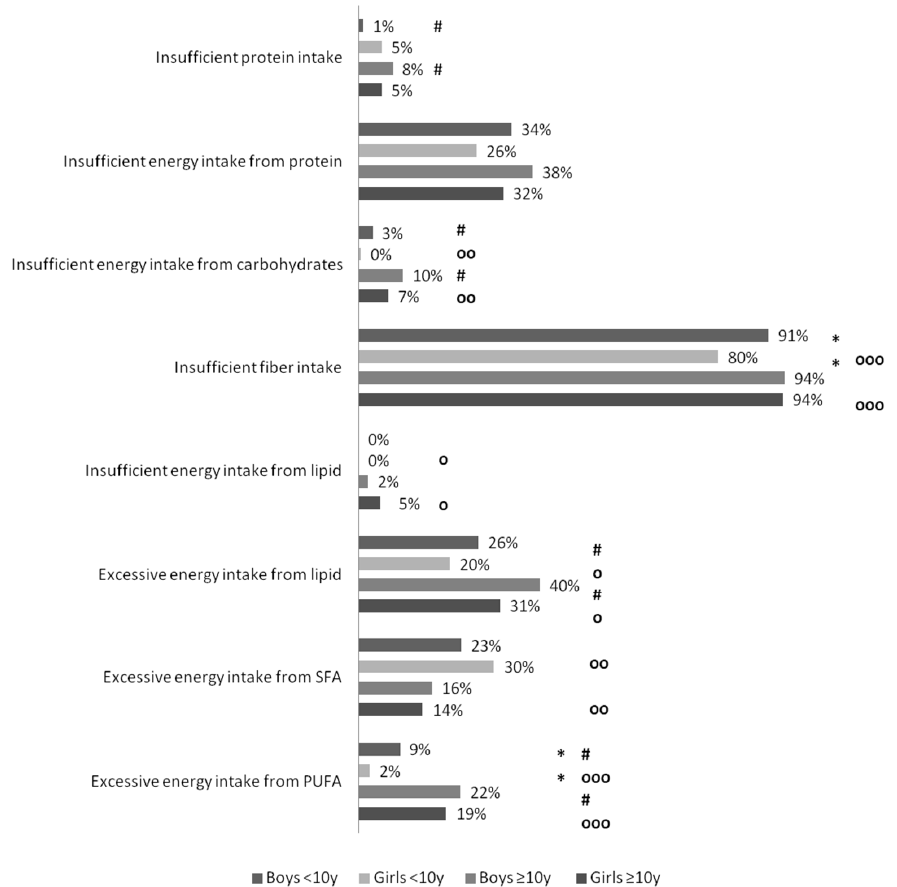
Figure 1. Prevalence of insufficient macronutrient intake according to age and gender group. %EI: Percent of energy intake; AMDR: Acceptable macronutrient distribution range; p ‐ value for χ 2 ‐ test between boys <10 years and girls <10 years; *: p ‐ value < 0.05; p ‐ value for χ 2 ‐ test between boys <10 years and boys ≥ 10 years; #: p ‐ value < 0.05; p ‐ value for χ 2 ‐ test between girls <10 years and girls ≥ 10 years: ooo: p ‐ value < 0.001; oo: p ‐ value < 0.01; o: p ‐ value < 0.05.